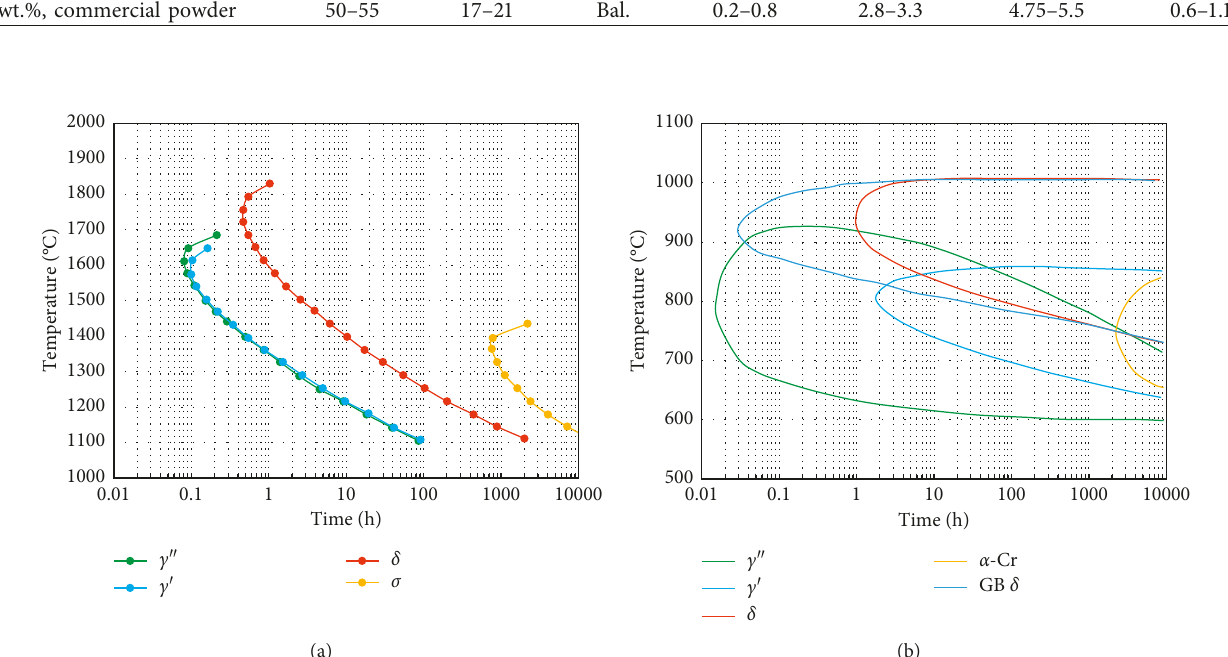
Figure 1: TTT diagram for IN718, calculated (a) and experimentally determined (b) [19,